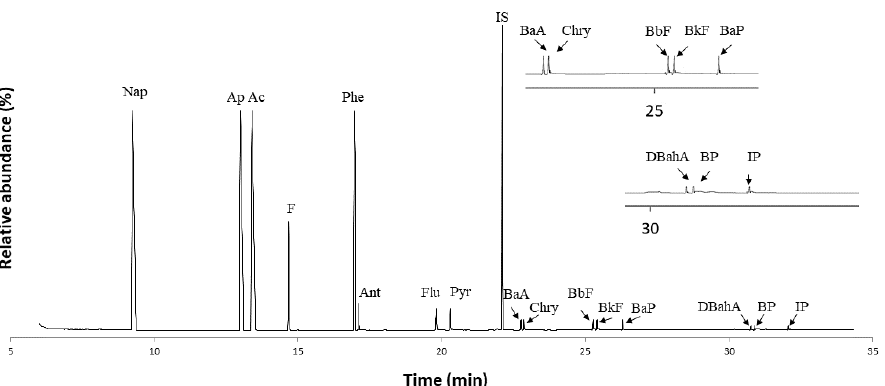
Figure 4. GC–MS chromatograms in the SIM mode for 1 g of whole cow’s milk spiked with a 500 ng/kg concentration of each PAH. For peak assignments, see Table 2. IS, internal standard.